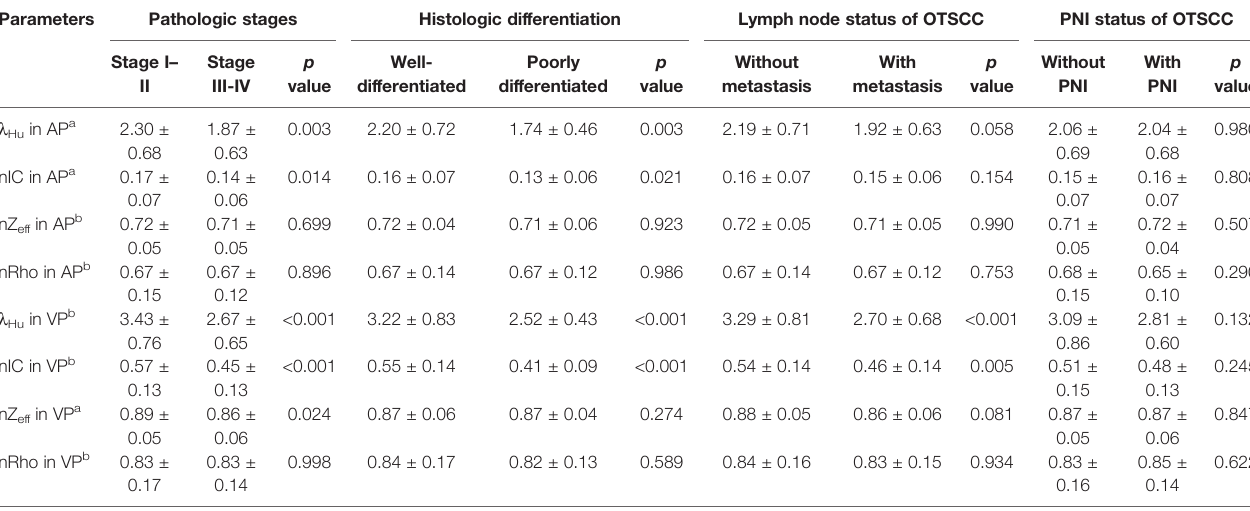
TABLE 2 | Quantitative DECT parameters between OTSCC patients with different aggressiveness (n = 93).